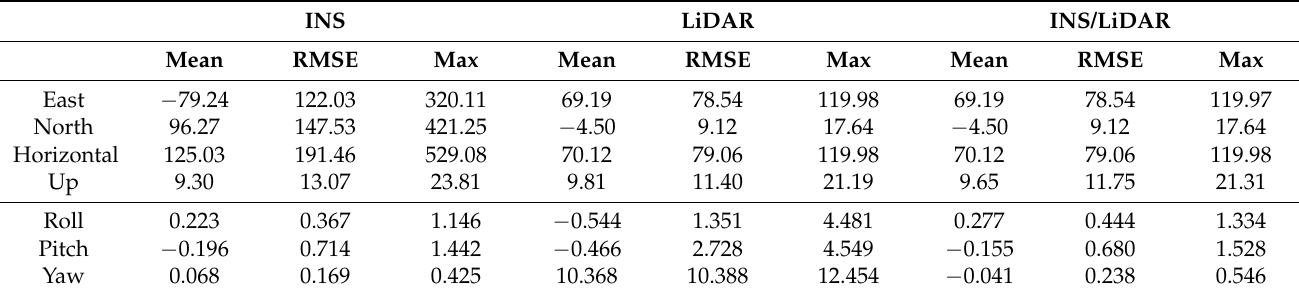
Table A8. D-34—position (m) and attitude (deg) error statistics.